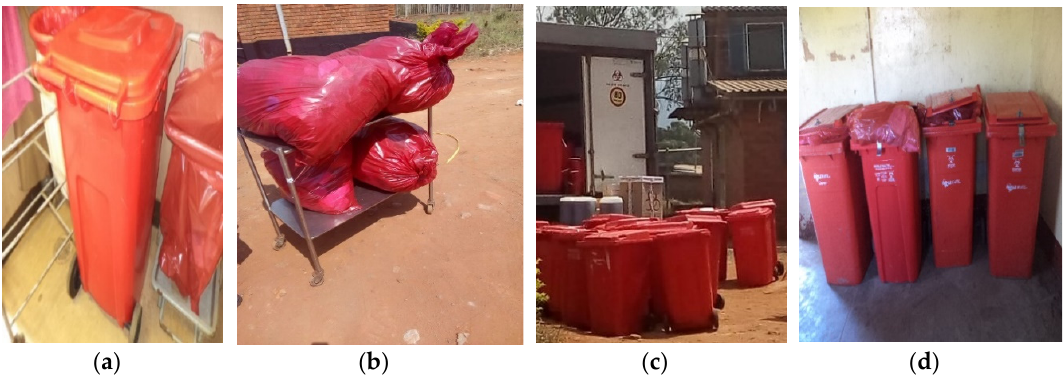
Figure 5. Photos taken by researcher during field work showing onsite transportation of HCRW: Wheelie bin in the sluice room of a healthcare facility ( a ); medication trolley being used to transport HCRW to the central storage area ( b ); HCRW being transported out of healthcare facility with wheelie bins ( c ) and overfull wheelie bins and some with faulty locks ( d ).